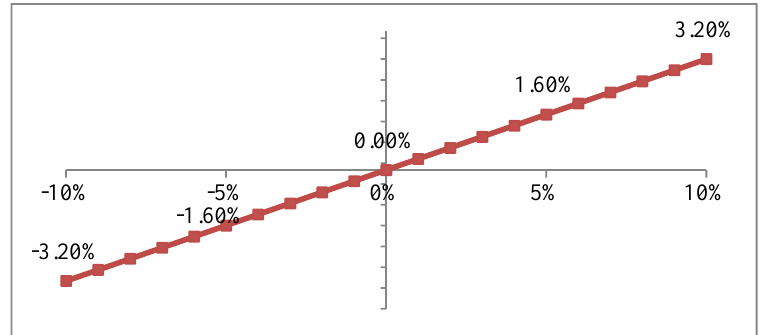
Figure 5. Annual changes in the cost of the central heating boiler under fluctuating coal prices.